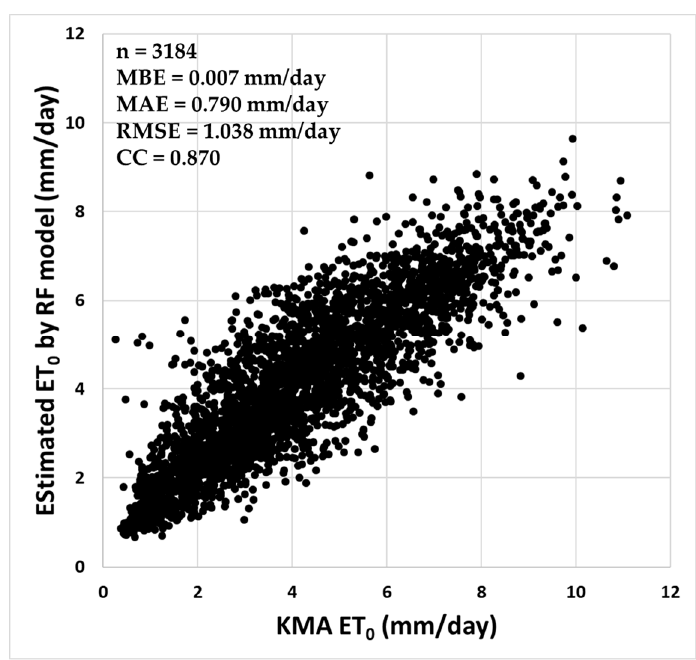
Figure 5. Scatterplot for the Korea Meteorological Administration (KMA) in situ daily ET 0 vs. estimated daily ET 0 in the blind test of the RF model in the croplands of South Korea, 2013–2019, with the accuracy statistics in terms of the mean bias error (MBE), mean absolute error (MAE), root mean square error (RMSE), and correlation coe ffi cient